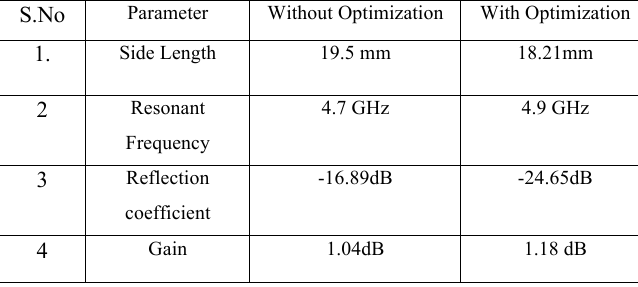
Figure 7: Comparative analysis of S11 of MTPA with and without circular cut in feed